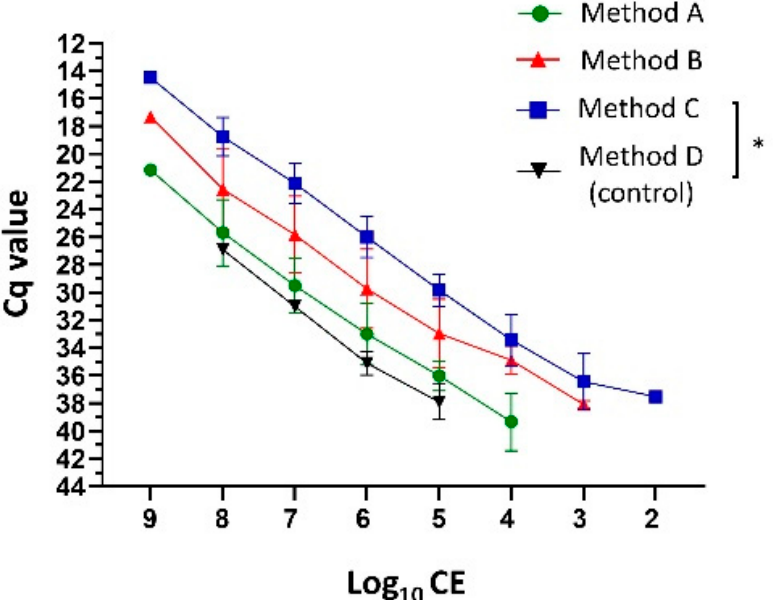
Figure 2. Cycle threshold (Cq) values relationship and comparison between the number